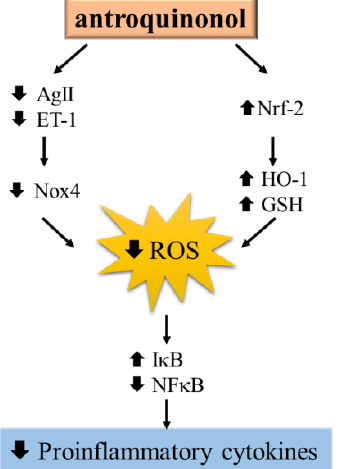
Figure 6. Antroquinonol improved oxidative stress and inflammation by upregulating the nuclear factor erythroid 2-related factor 2 (Nrf)-2 pathway and modulating NADPH oxidase-4 (NOX4) activity in rats with endothelial dysfunction.